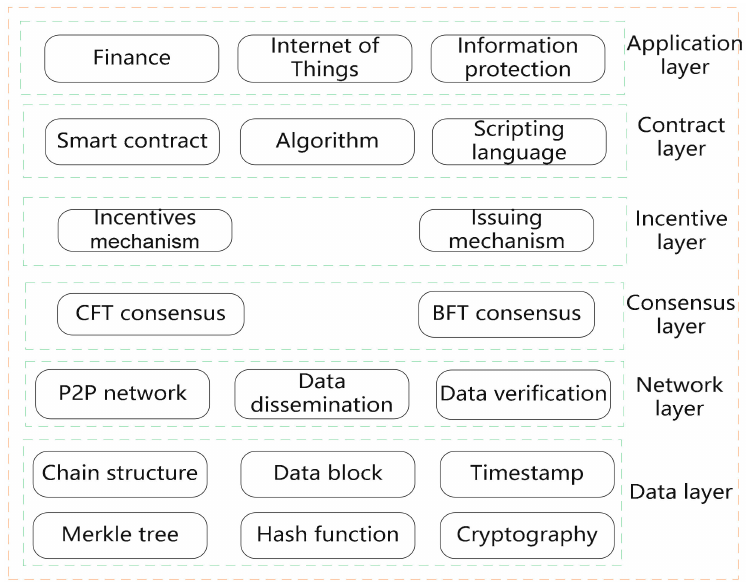
Figure 2. Blockchain structure